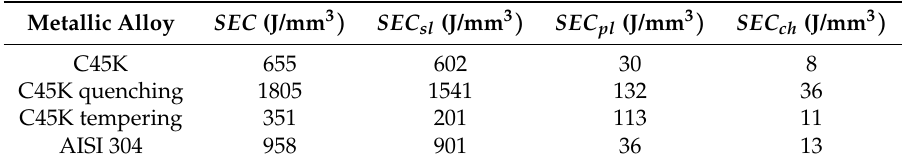
Table 3. Average specific energy consumption of different indices in plane dry grinding.